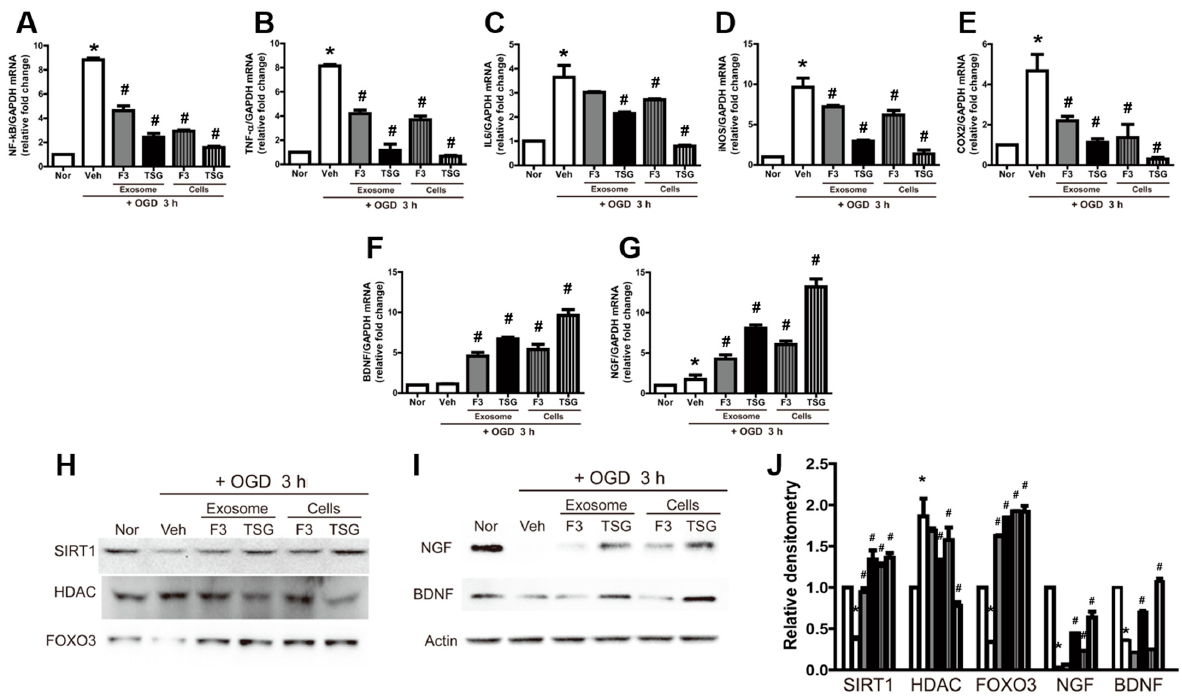
Figure 3. Reversal of OGD-induced changes by exosomes in N2A cells. (A–G) Real-time PCR analysis of mRNA of the inflammatory factors nuclear factor (NF)- κ B (A), tumor necrosis factor (TNF)- α (B), interleukin 6 (IL-6) (C), inducible nitric oxide synthase (iNOS) (D), and cyclooxygenase 2 (COX2) (E) and the neurotrophin family members brain-derived neurotrophic factor (BDNF) (F) and nerve growth factor (NGF) (G). They were normalized to glyceraldehyde-3-phosphate dehydrogenase (GAPDH); (H–J) Western blot analysis of sirtuin 1 (SIRT1), histone deacetylase (HDAC), and forkhead box O-3 (FOXO3) proteins showing representative bands (H), NGF and BDNF showing representative bands (I); band densities normalized to actin (J). Densitometric analysis of the Western blot was performed using ImageJ. n = 3 per treatment group. * Significantly different from normal control ( p < 0.05). # Significantly different from vehicle control ( p < 0.05).